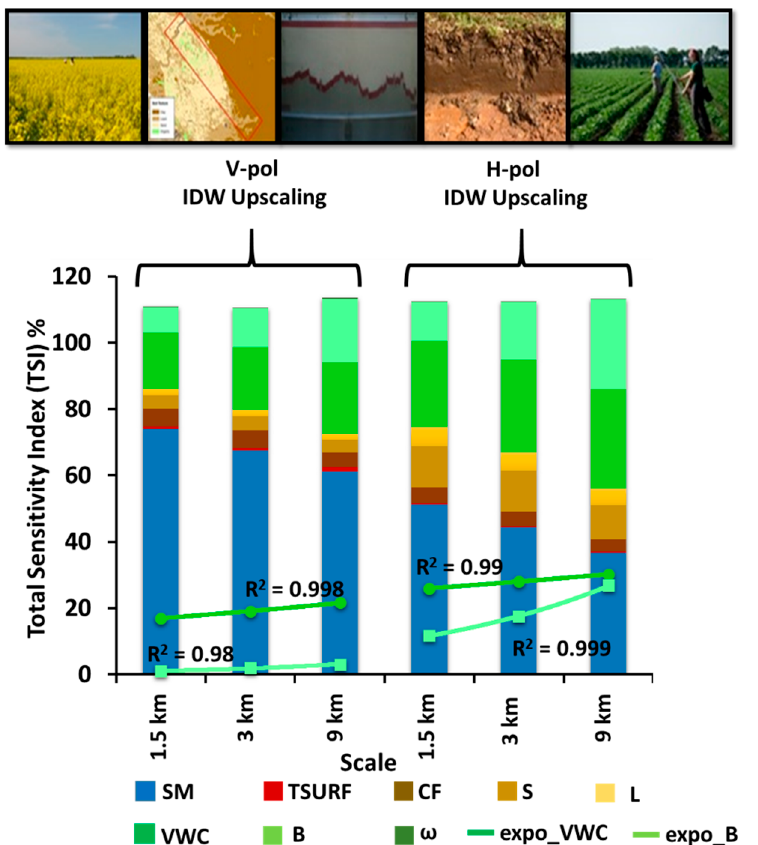
Figure 6. Soil Moisture Active Passive Experiments 2012 (SMAPVEX12), Total Sensitivity Index (TSI) for Brightness Temperature under V-polarization, and H-polarization using Inverse Distance Weighted (IDW). SM: Soil Moisture; CF: Clay Fraction; S: Root Mean Square Height; L: Correlation Length; TSURF: Surface Temperature; VWC: Vegetation Water Content; B: Vegetation Structure; ω : Single Scattering Albedo. The green and mint-green curves represent an exponential fit to VWC (expo_VWC, V-pol: R 2 = 0.998 & H-pol: 0.99) and to B (V-pol: R 2 = 0.98 & H-pol: 0.999). The symbols represent the TSI values of the respective variables, while R 2 represents the goodness of fit.